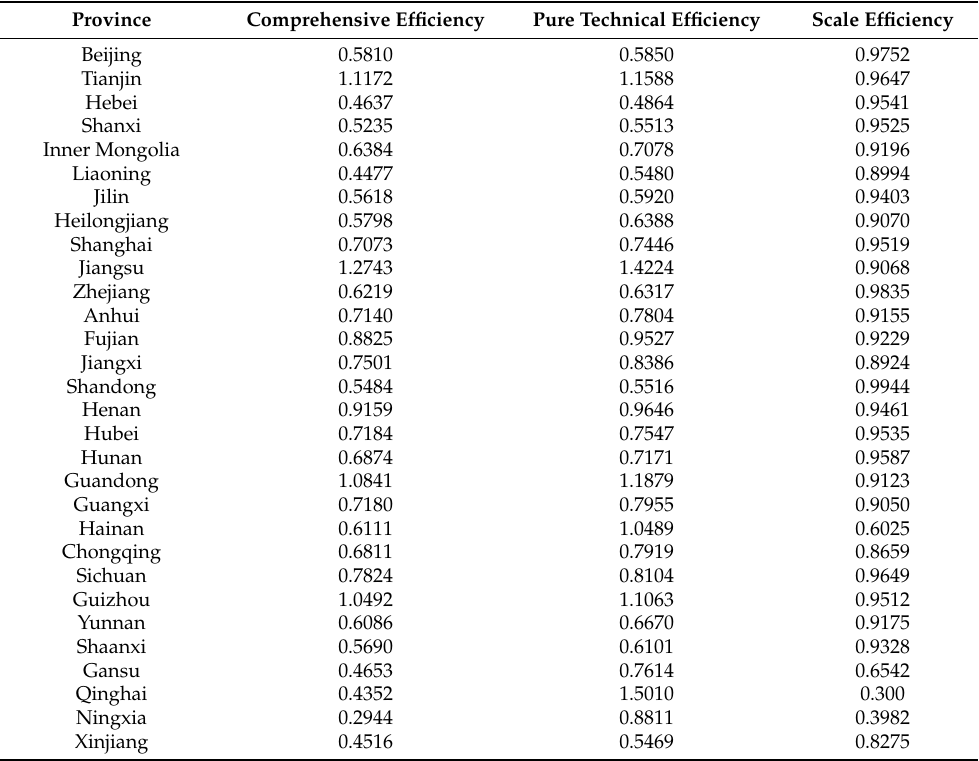
Table 4. China’s provincial tourism carbon emission efficiency calculation